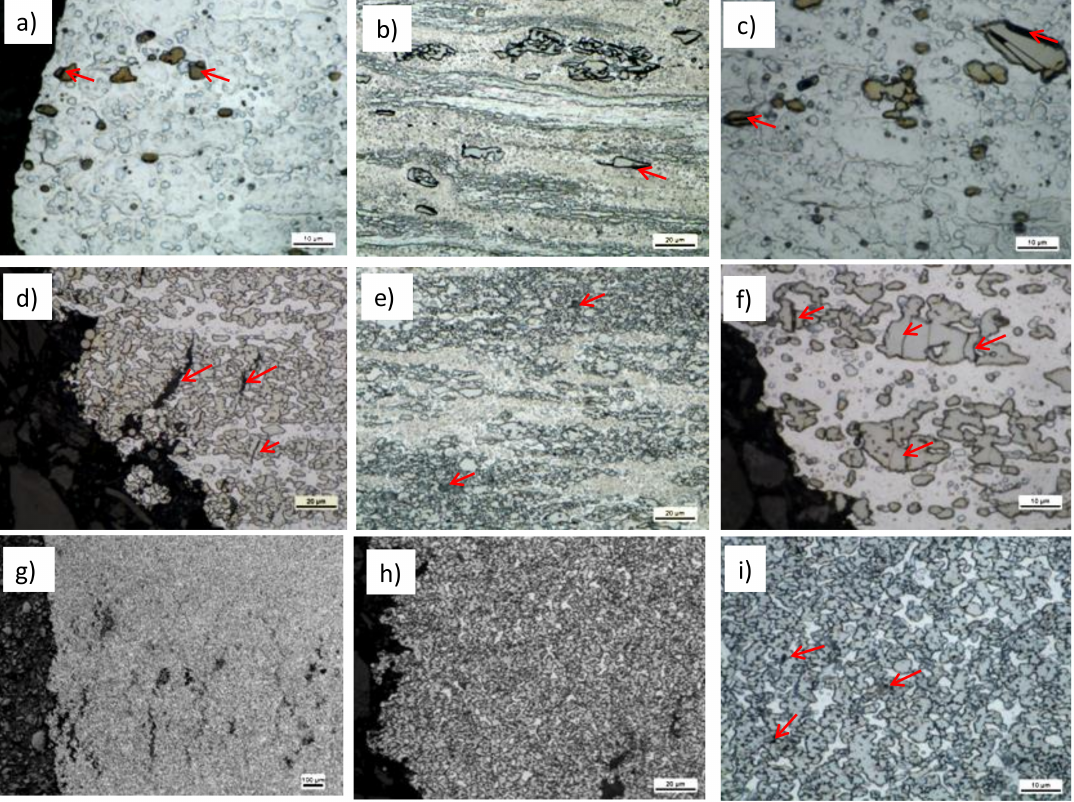
Figure 9. Microstructure of Al–Cu alloys after tensile test at 400 ◦ C: ( a – c ) Al 5 Cu alloy, ( d – f ) Al 25 Cu alloy, ( g – i ) Al 33 Cu